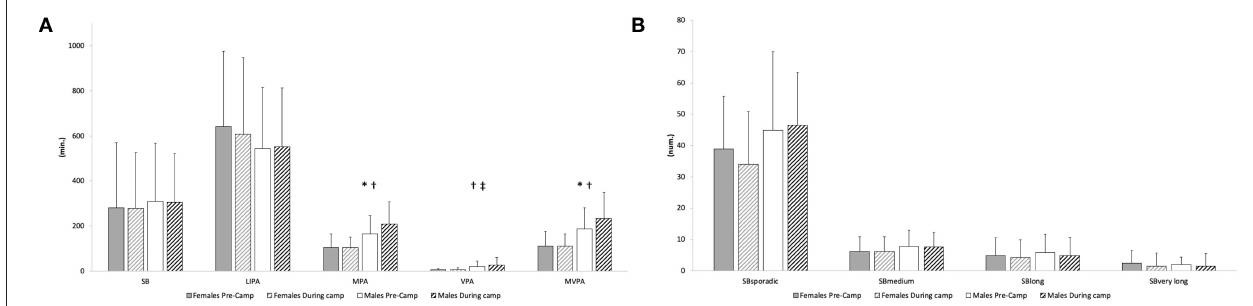
FIGURE 1 | (A) Physical activity and sedentary behavior before and during camping. (B) sedentary episodes of different length before and during camping. SB, sedentary behavior; LIPA, light-intensity physical activity; MPA, moderate-intensity physical activity; VPA, vigorous-intensity physical activity; MVPA, moderate- to vigorous-intensity intensity physical activity; SB sporadic , sedentary behavior shorter than 6min; SB medium , sedentary behavior between 6 and 10min; SB long , sedentary behavior between 11 and 30min; SB verylong , sedentary behavior episodes longer than 30min. *Significant difference between male and female participants before camping. † Significant increase in male participants during the camp. ‡ Significant difference between male and female participants during the